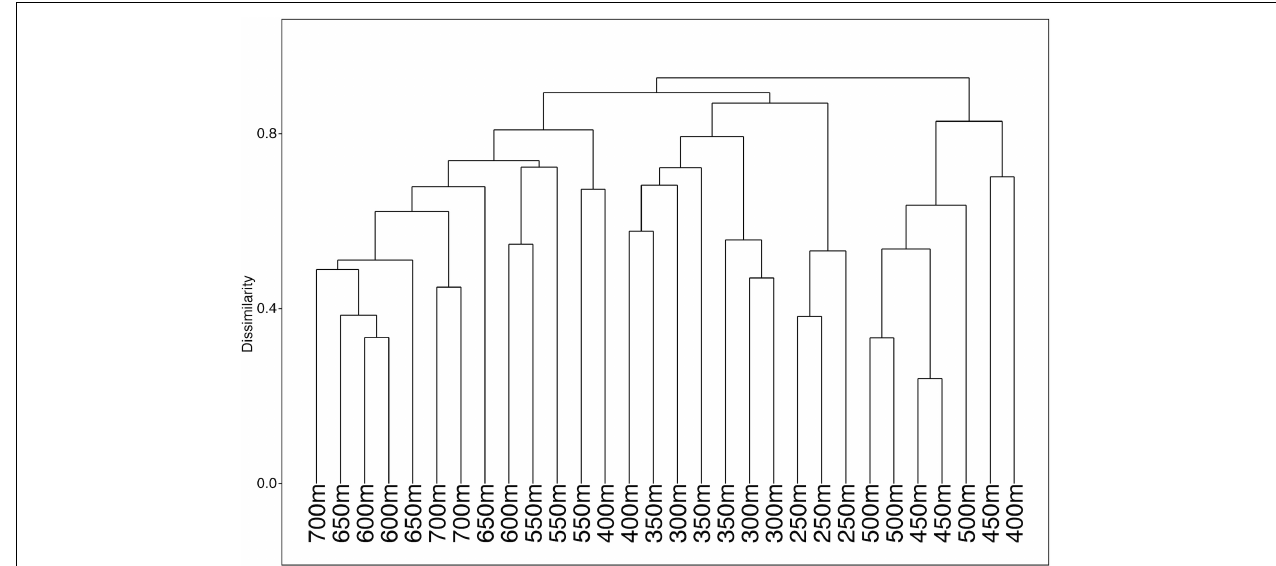
FIGURE 4 | Hierarchical cluster diagram for the North side of Mokumanamana for transects labeled by depth bin.